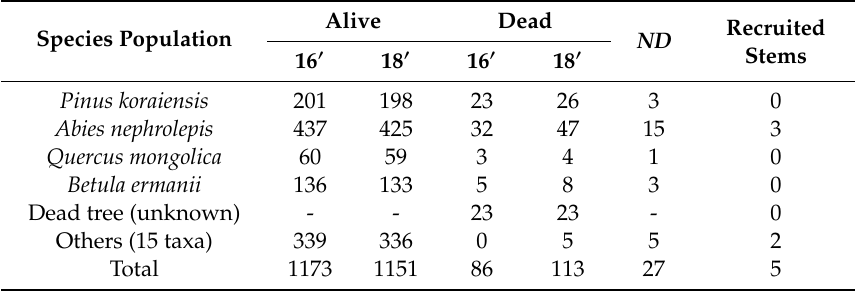
Table 2. Short-term dynamics of tree density in quadrat plots for two years (2016 and 2018).